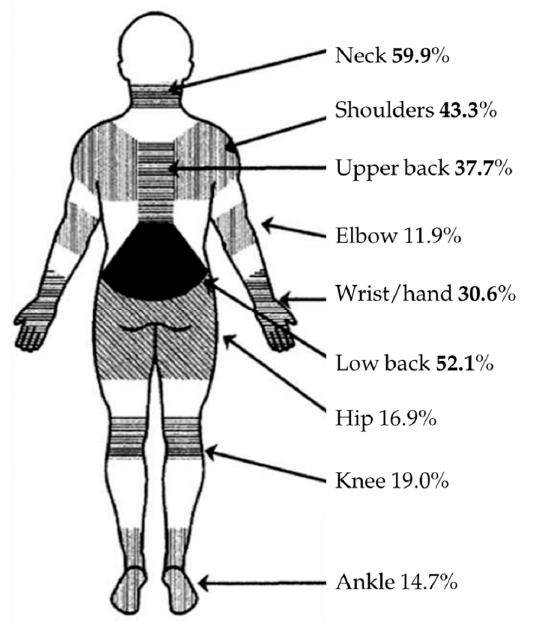
Figure 4. Frequency of WMSD and distribution according to body regions.